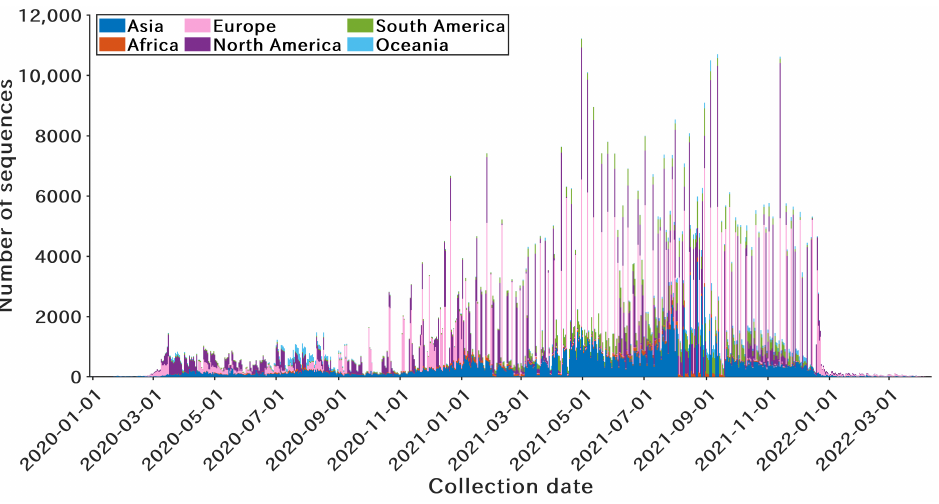
Figure 2. Temporal and spatial distribution of the extracted SARS-CoV-2 genome sequences. A total of >1 million SARS-CoV-2 genome sequences are downloaded from the GISAID